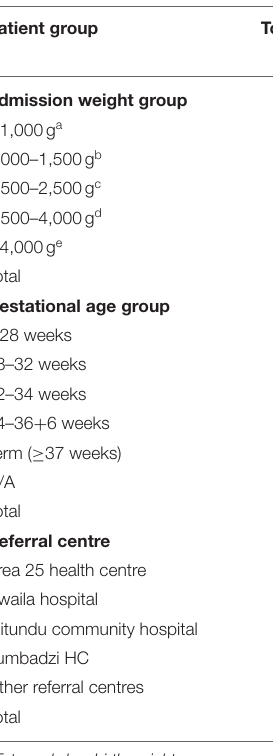
TABLE 3 | CFRs in different patient